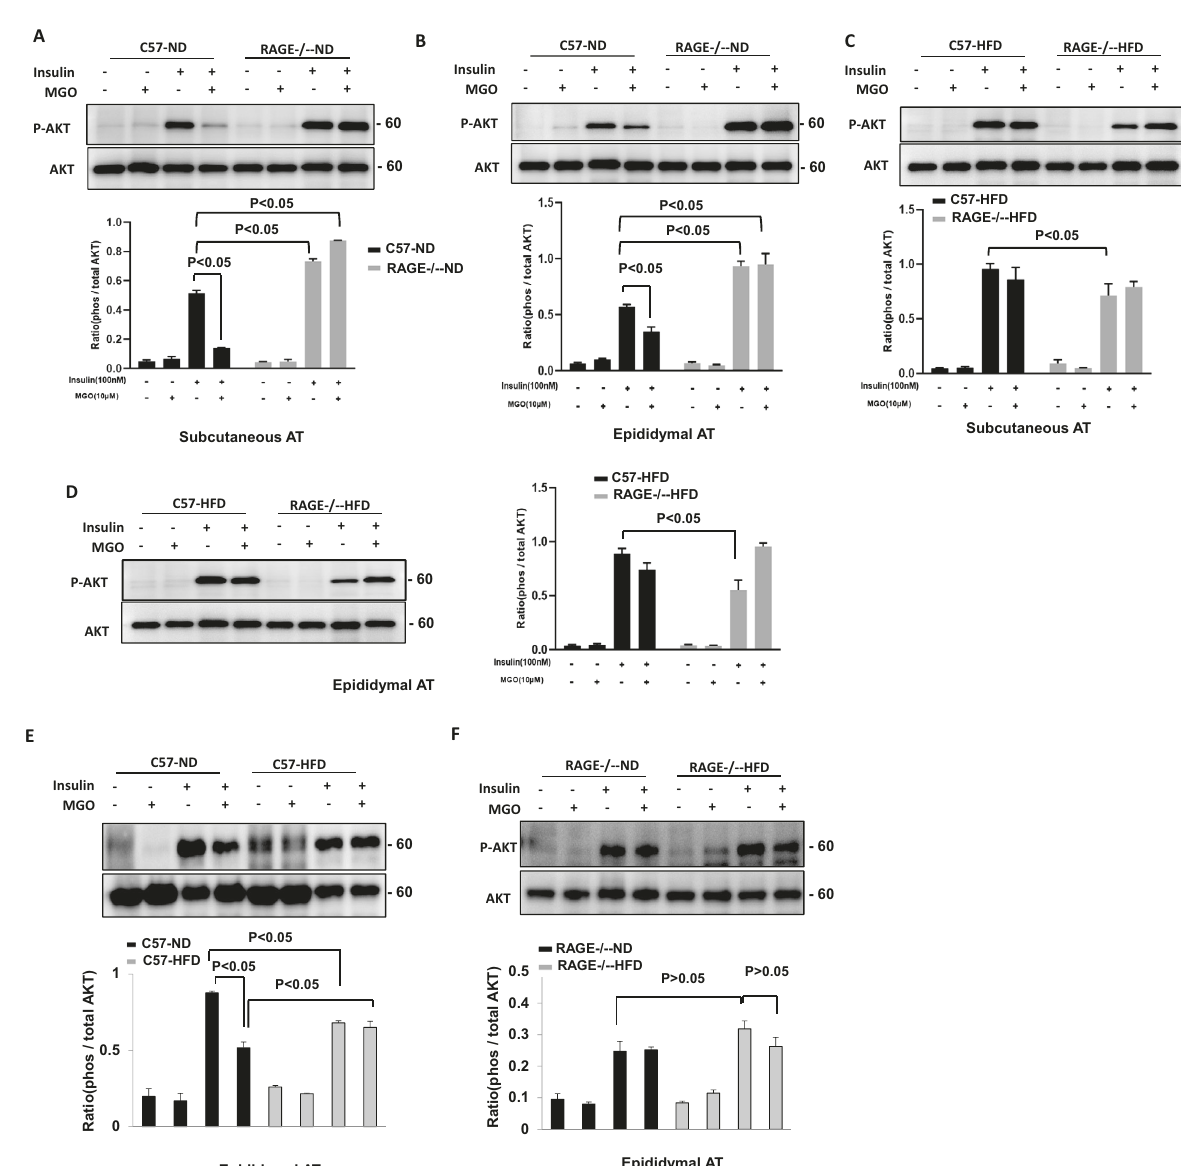
Fig. 3 RAGE de fi ciency protects MGO-inhibited insulin signaling in adipose tissue. The treatment of insulin (100nM) for 10 mins stimulated Ser 473 phosphorylation of AKT after pretreatment with MGO (10 µM) for 16 h in AT explants from WT and RAGE − / − mice. Representative immunoblots and quanti fi cation of subcutaneous AT (sAT) ( A ) and eAT ( B ) from normal diet (ND) mice. Representative immunoblots and quanti fi cation of sAT ( C ) and eAT ( D ) from HFD mice as indicated. E , F Comparison of AKT phosphorylation from either ND or HFD mice with the same strain as indicated. All graphs correspond to the adjacent blots above and represent densitometric analyses of 3 independent experiments. P -values indicating the signi fi cance of difference are indicated in the respective bar diagrams. All group data are shown as mean ±